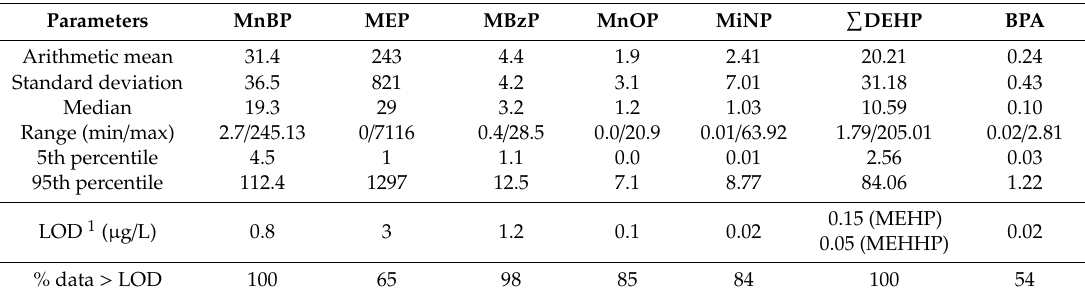
Table 3. Analytical results of urinary metabolites of phthalates and BPA, corrected for creatinine levels ( µ g / g